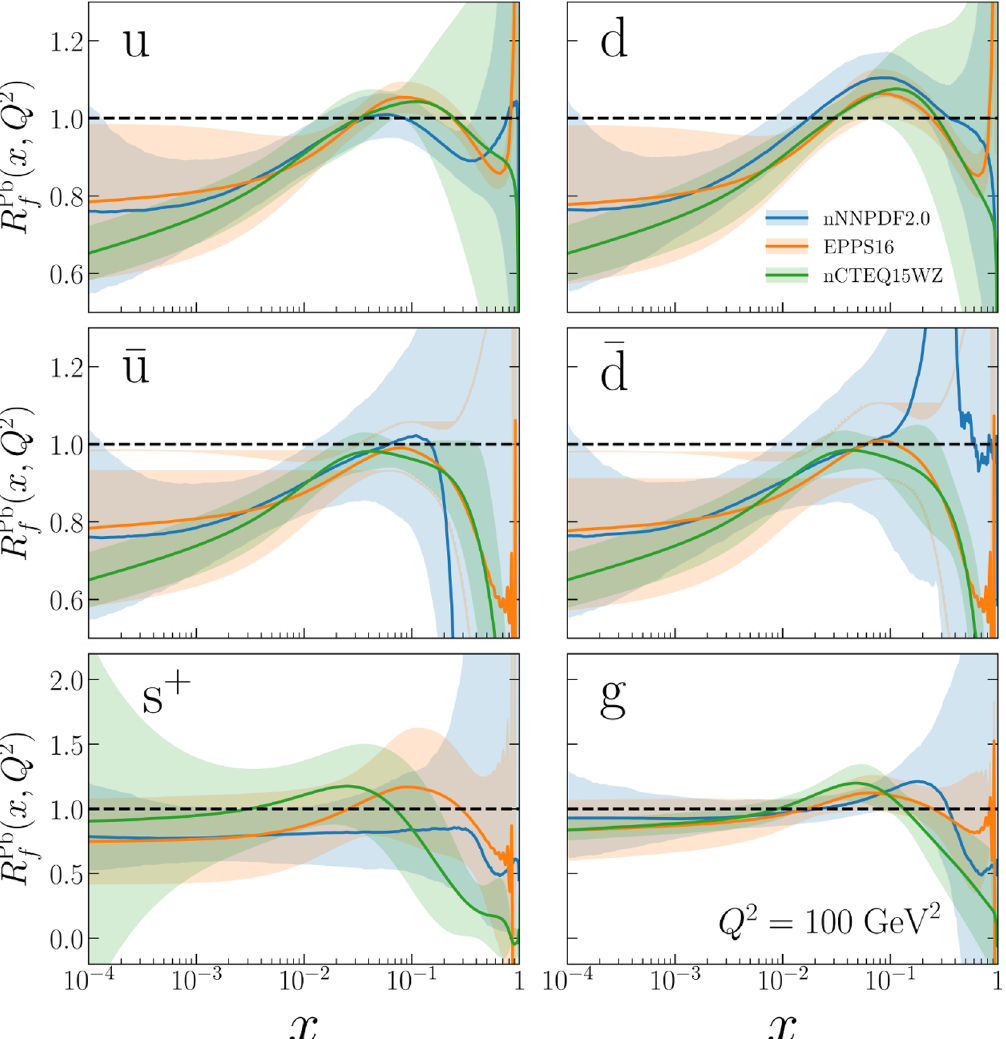
Figure 14 . Same as (cid:12)gure 13 in the case of lead nuclei, R Pb ( x; Q 2